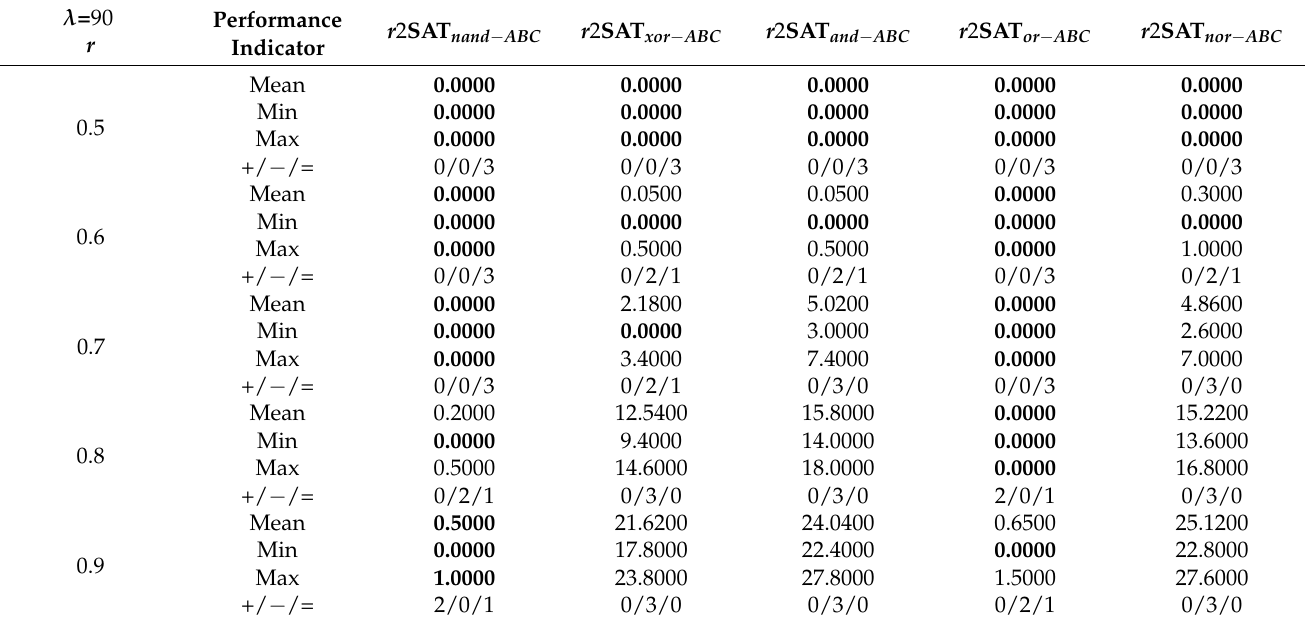
Table 14. Comparison of r 2SAT nand − ABC against other logic gates in terms of MAE for λ = 90. λ =